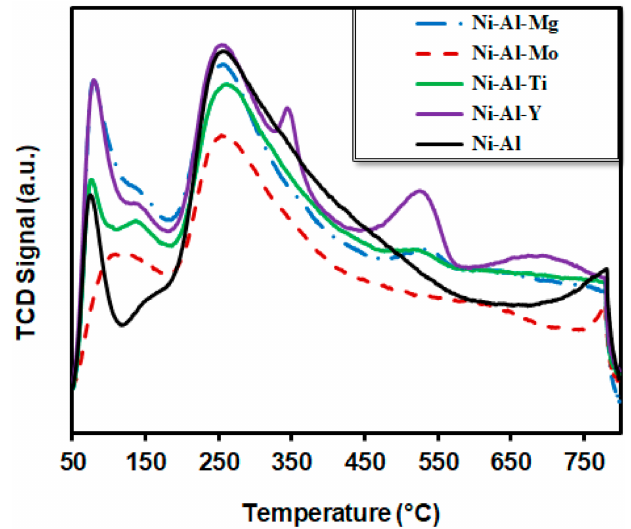
Figure 4. Represents the CO 2 -temperature-programmed desorption (TPD) profiles of the Ni-Al-x (x = 0, Mo, Ti, Y, and Mg)